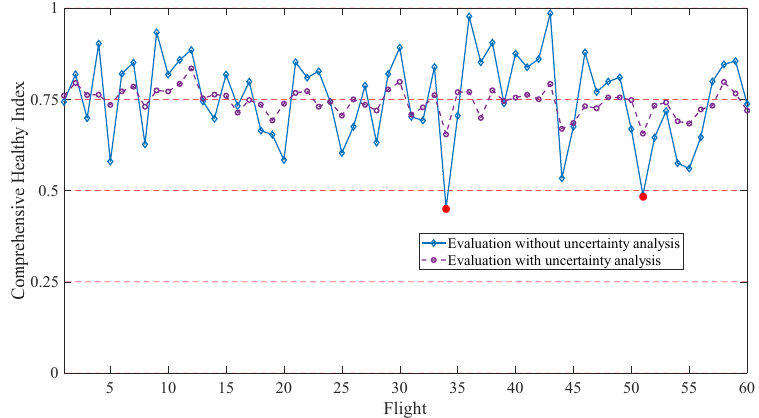
Figure 12. Comparison of assessment results with and without uncertainty.